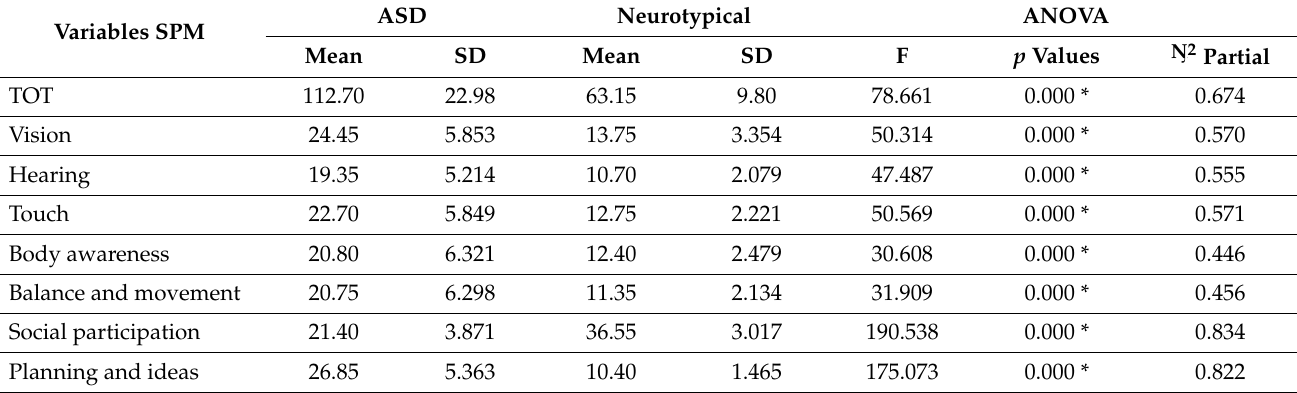
Table 2. Data relating to the analysis of the qualitative variables of both groups. ASD Neurotypical Variables